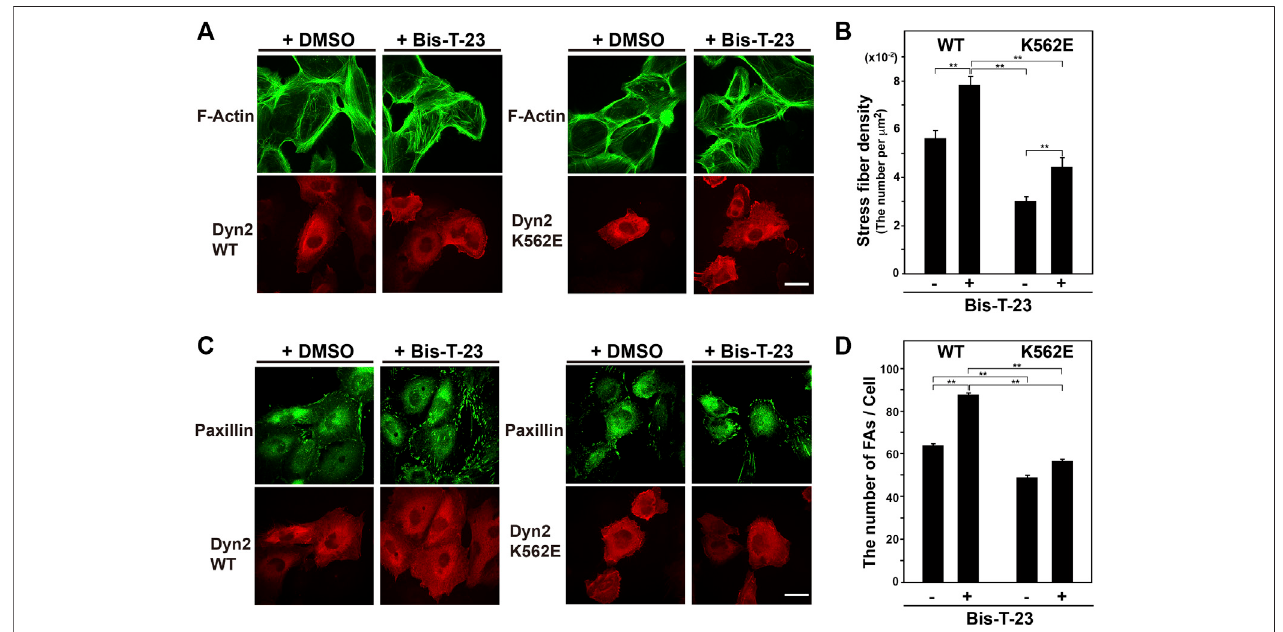
FIGURE 3 | Stress fi bers and focal adhesions increase in Bis-T-23-treated HPCs. (A) Double-immuno fl uorescence of V5-tagged dynamin 2 (Dyn2)-WT or K562E (bottompanels)andactin fi laments(toppanels)inBis-T-23-treated(50 μ M)HPCsandcorrespondingsolventcontrols(DMSO).Scalebar:20 μ m. (B) Stress fi berdensity inBis-T-23-treateddynamin2-WT-orK562E-expressingHPCs.Dataaremeans±S.E.M.of35cells(dynamin2-WT/DMSO),33cells(dynamin2-WT/Bis-T-23),38cells (dynamin 2-K562E/DMSO) or 35 cells (dynamin 2-K562E/Bis-T-23) from three independent experiments. (** p < 0.01). (C) Double-immuno fl uorescence of V5- tagged dynamin 2-WT or K562E (bottom panels) and paxillin (top panels) in Bis-T-23-treated (50 μ M) HPCs and corresponding solvent controls (DMSO). Scale bar; 20 μ m. (D) NumberoffocaladhesionsinBis-T-23-treateddynamin2-WT-orK562E-expressingHPCs. Dataaremeans±S.E.M.of35cells(dynamin 2-WT/DMSO), 32 cells(dynamin2-WT/Bis-T-23),35cells(dynamin2-K562E/DMSO)or34cells(dynamin2-K562E/Bis-T-23)fromthreeindependentexperiments.(** p < 0.01).morethan 32 cells from three independent experiments. (** p <